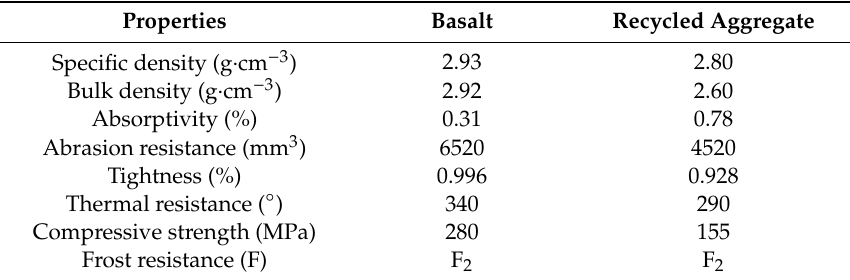
Table 4. Properties of basalt and recycled aggregates (own research).